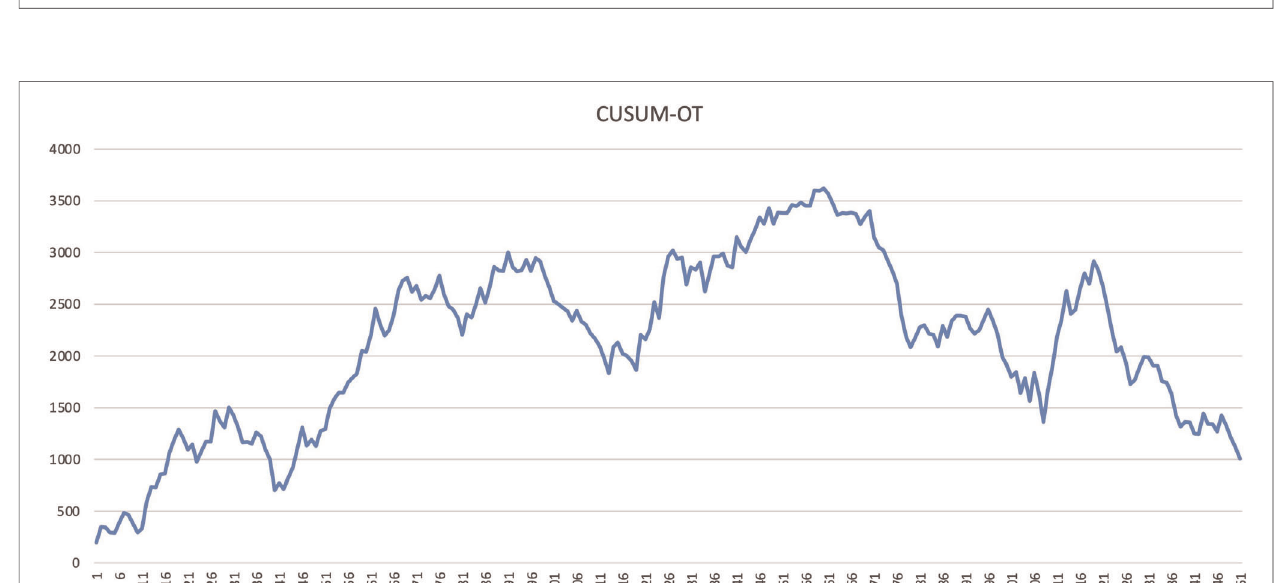
FIGURE 2 | Risk-adjusted CUSUM curve